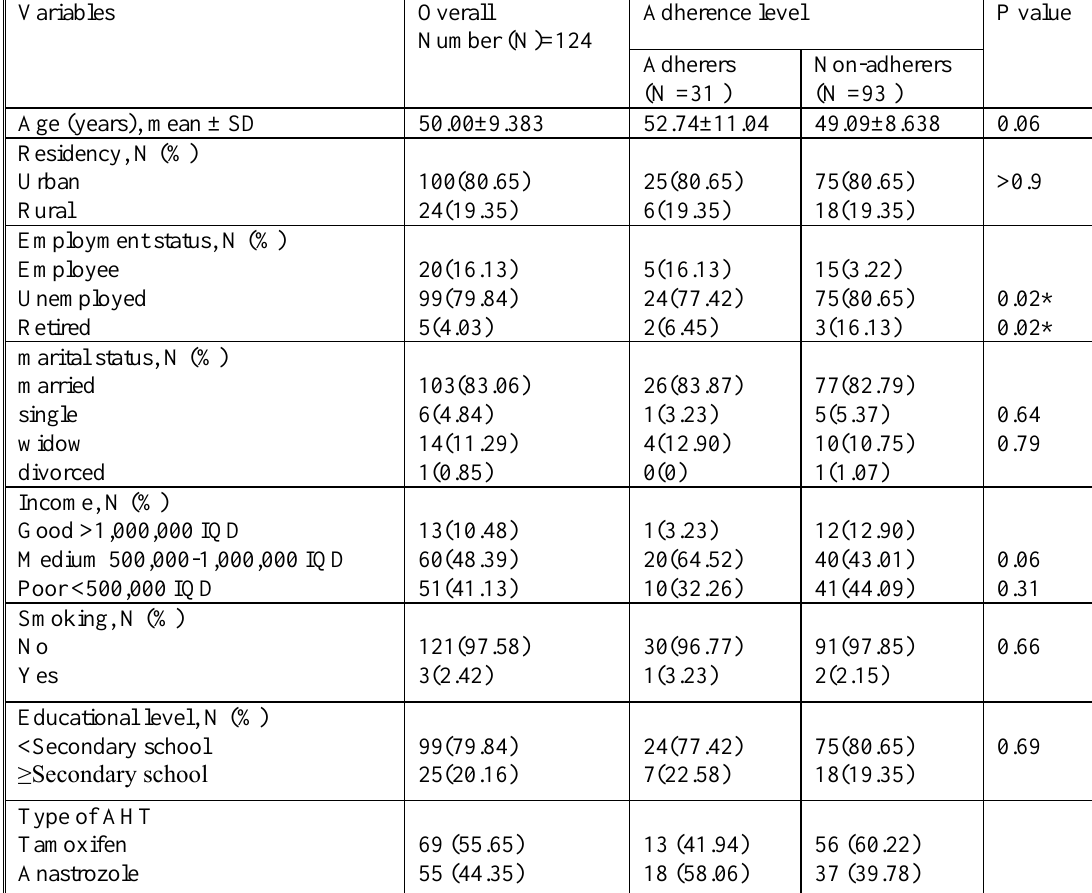
Table 1. Sociodemographic and clinical characteristics of participants